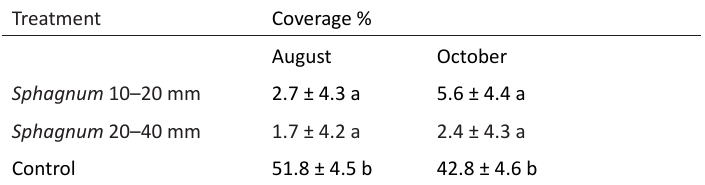
Table 1. Mean values and SE of liverwort coverage % on pot surface of rhododendron. Surface was covered with 2 cm of different coarseness of Sphagnum moss M. Different letters in one column indicate statistical difference p ≤0.05. Treatment